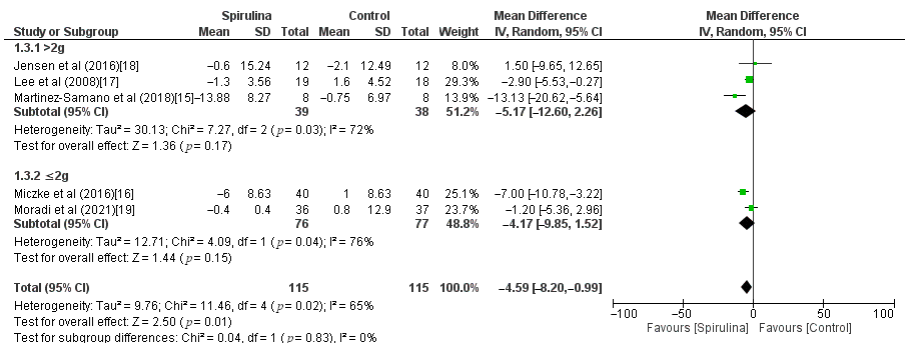
Figure 3. Effect of Spirulina supplementation on systolic blood pressure (SBP) compared with the control group [15–19].